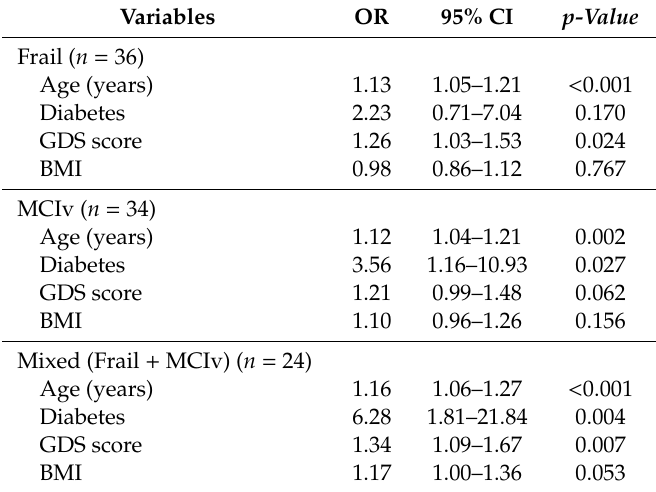
Table 3. Association of frail, MCIv and mixed groups and their covariates using a multinomial logistic regression